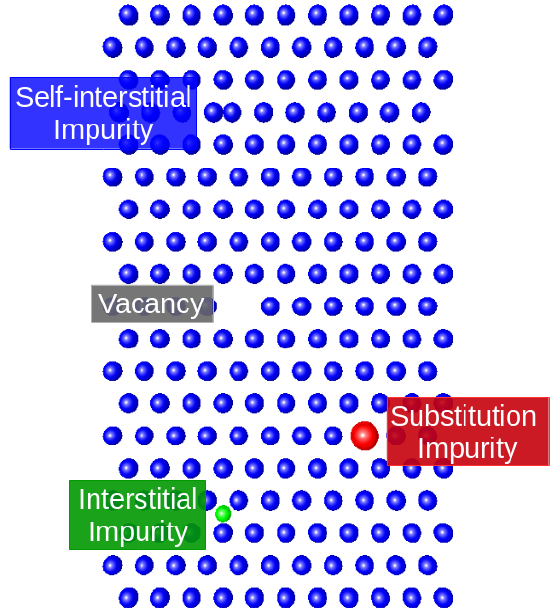
Figure 1. Examples of various types of disorder, including substitution and interstitial impurities, and vacancies. In addition (not shown), disorder can originate from other ways of breaking the translational symmetry, including the external disorder potentials, amorphous systems, random arrangement of spins,